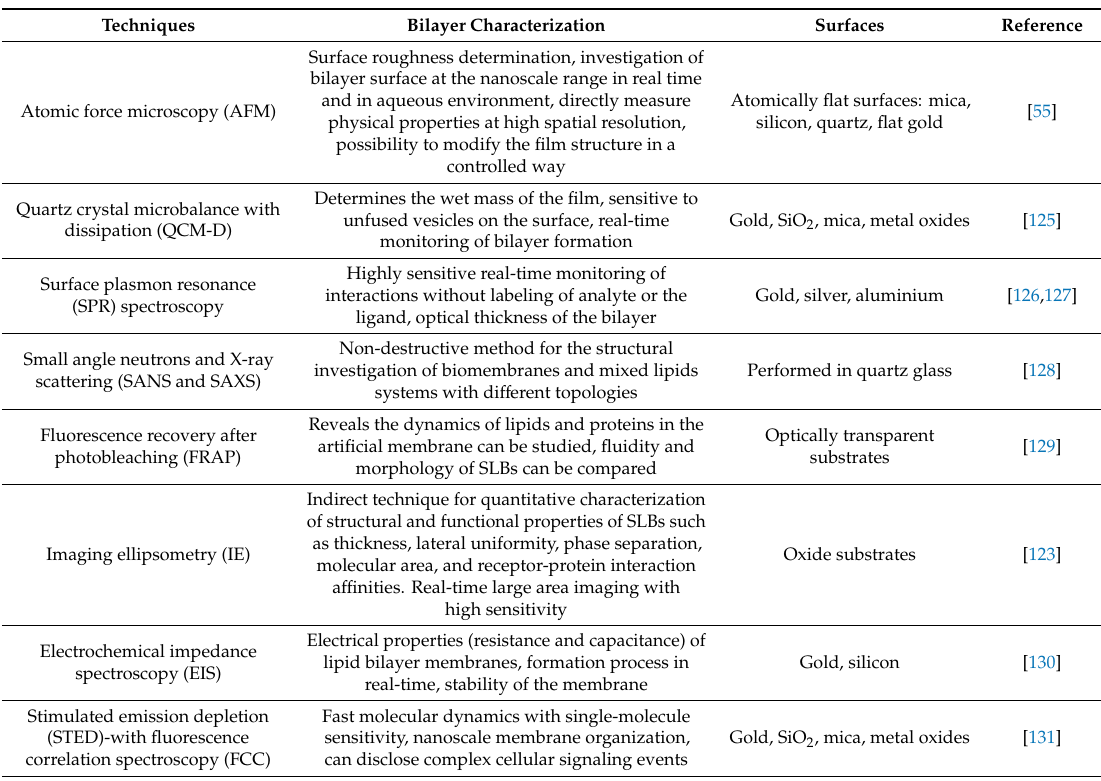
Table 3. Summary of techniques useful for surface supported bilayer